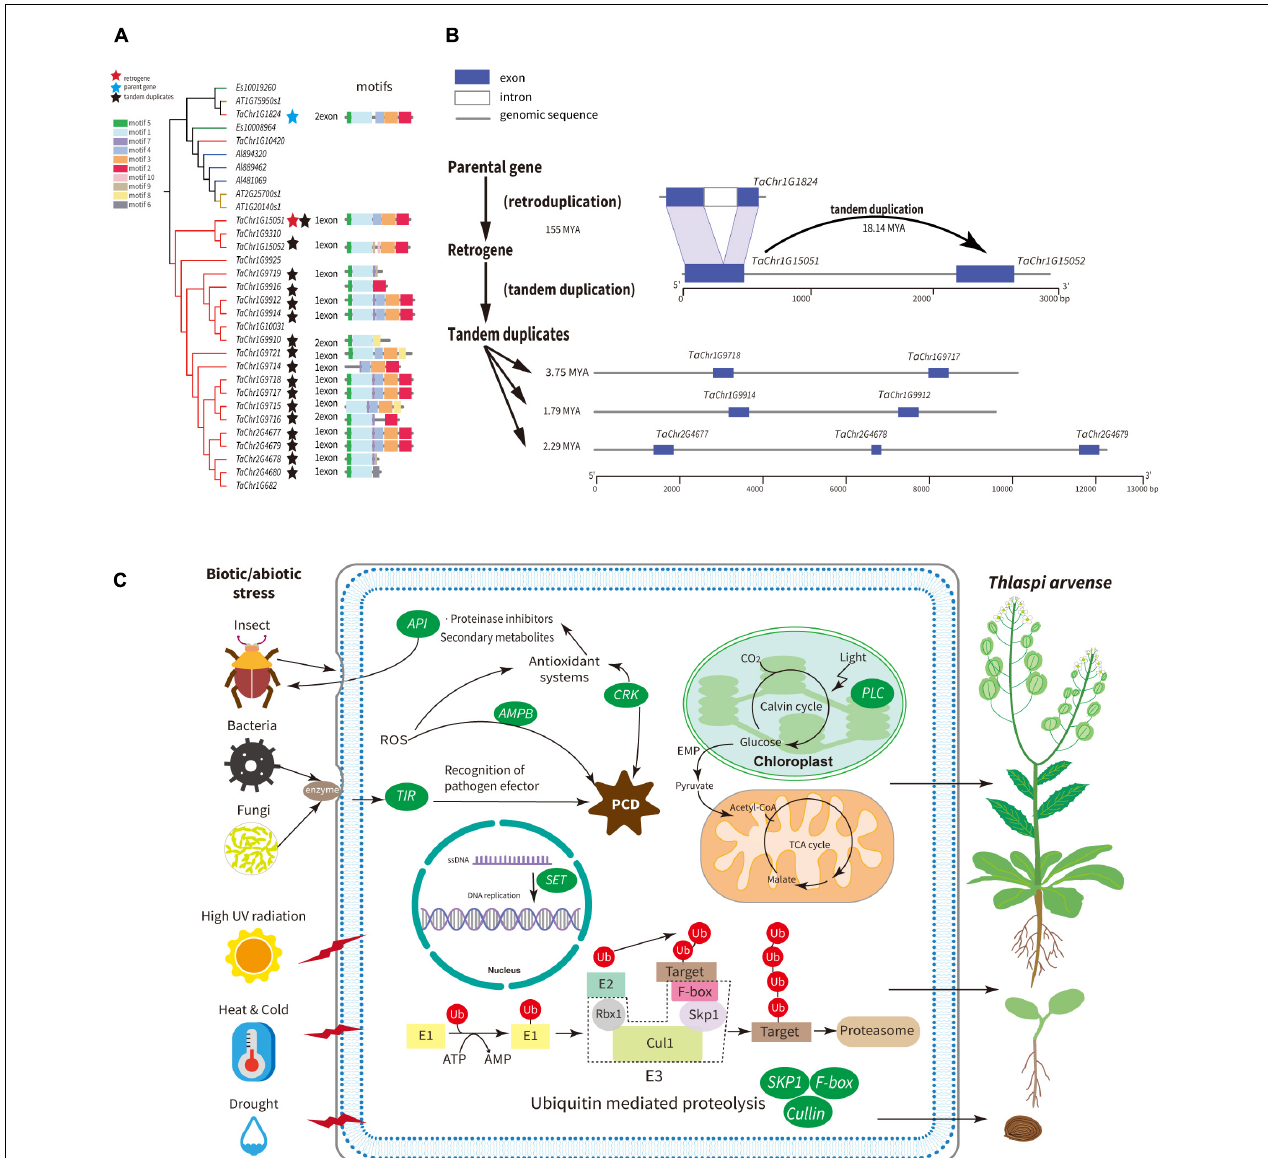
FIGURE 5 | Schematic summary of adaptive strategies of T. arvense. (A) Phylogenetic relationships, motifs of the SKP1 gene family between T. arvense (gene id with “TaChr”), E. salsugineum (gene id with “Es”), A. lyrata (gene id with “Alyrata”), and A. thaliana (gene id with “AT”). The blue star indicates the parental gene; red star indicates the retrogene; dark stars indicate tandem duplicates. (B) Models for the evolution of SKP1 genes, as one example family that induced by the mechanism that retroduplication followed by subsequent tandem duplication of homologous genes. (C) Expanded gene families induced by RNA-based and tandem gene duplication are shown in green ovals, which are related to growth and development and stresses responses in T. arvense